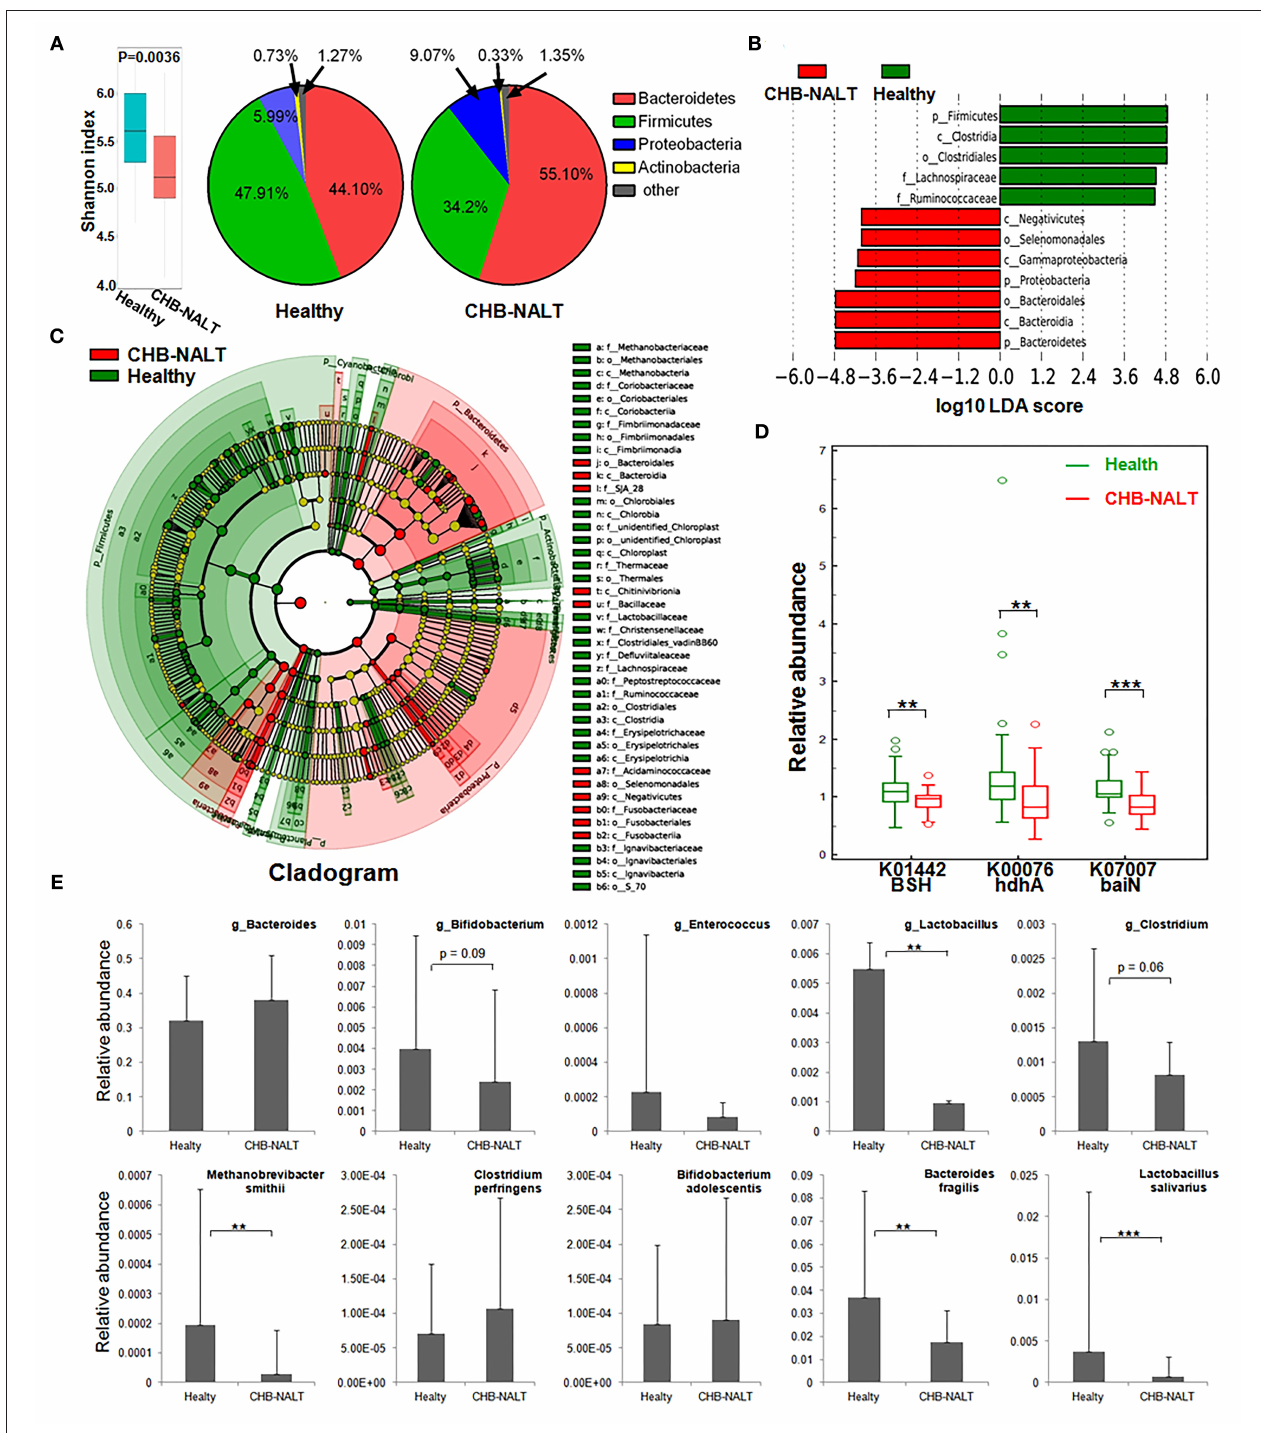
FIGURE 4 | Modulation of fecal microbial profiles and functionalities related to CHB-NALT. (A) Shannon index of microbial ecological diversity and microbiota constituents at phylum level shown difference between groups. Linear discriminant analysis (LDA) coupled with effect size measurements identifies the taxons most differentially abundant between the groups. (B) Taxa with LDA significant cutoff > 4 were shown. (C) Taxa with LDA > 2 were summarized by cladogram. (D) Taxa overrepresented in CHB-NALT (red) or healthy controls (green) were highlighted according to LEfSe analysis. The predicted gene abundance of BSH (KEGG orthology K01442), hdhA (K00076) and baiN (K07007) between the groups. (E) The relative abundances of BSH containing genus (top panel) and bacteria species (bottom panel) between the groups. P values were determined by the Mann–Whitney U test, significant differences were noted by * p < 0.05, ** p < 0.01, *** p < 0.001. Data were presented by median ±